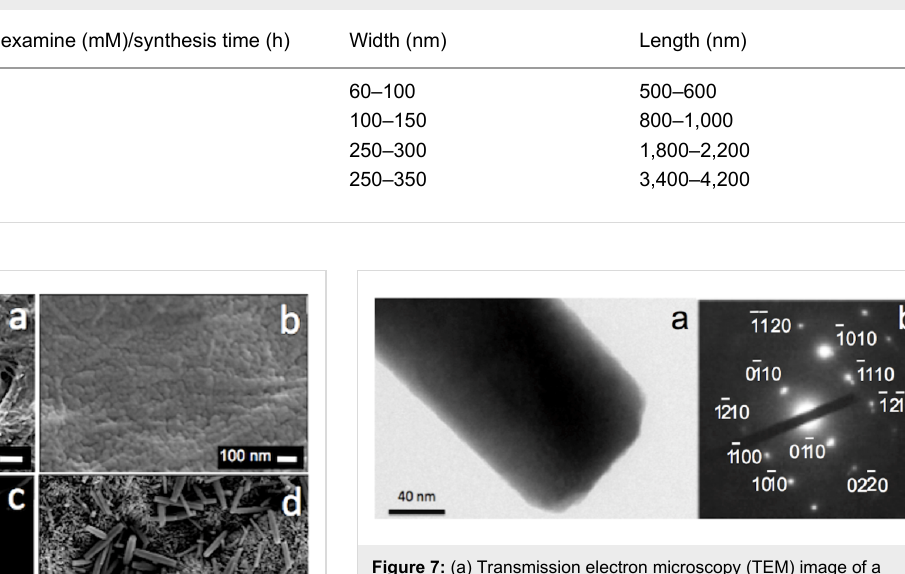
Figure 7: (a) Transmission electron microscopy (TEM) image of a single ZnO nanorod (b) Electron diffraction pattern showing the single crystalline structure. The planes from which the electron beam was diffracted to generate the diffraction pattern are indexed in the diffrac-